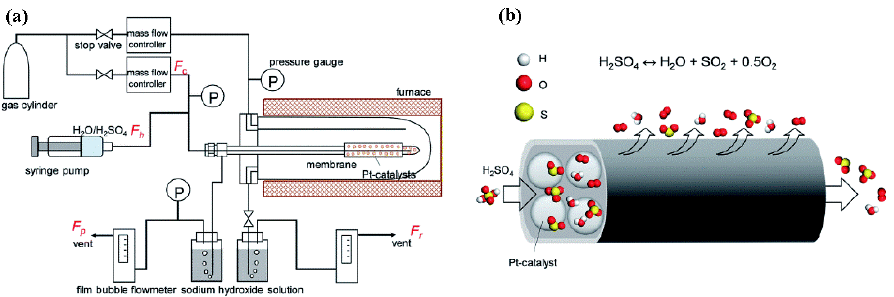
Figure 27. ( a ) Schematic of an experiment for steam and H 2 SO 4 treatment and gas permeation; ( b ) schematic of the SiC membrane used for H 2 SO 4 decomposition in a membrane reactor at 600 °C. Reprinted from [34] with permission.